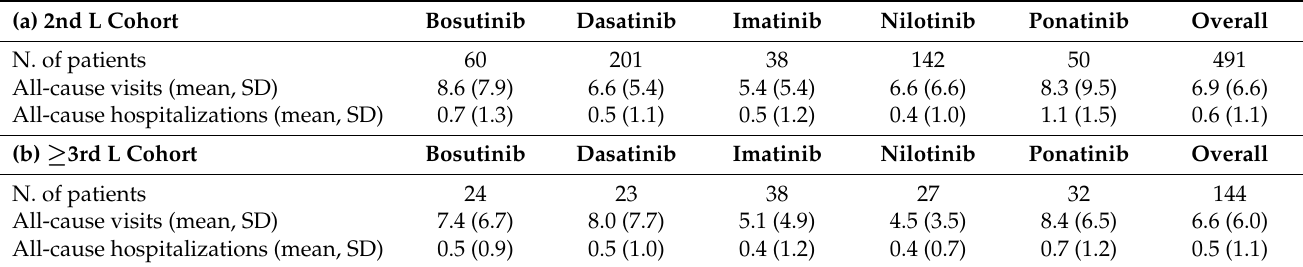
Table 4. Mean annual number of annual consumptions of healthcare resources of 2nd L ( a ) and ≥ 3rd L ( b ) cohorts, overall and by type of